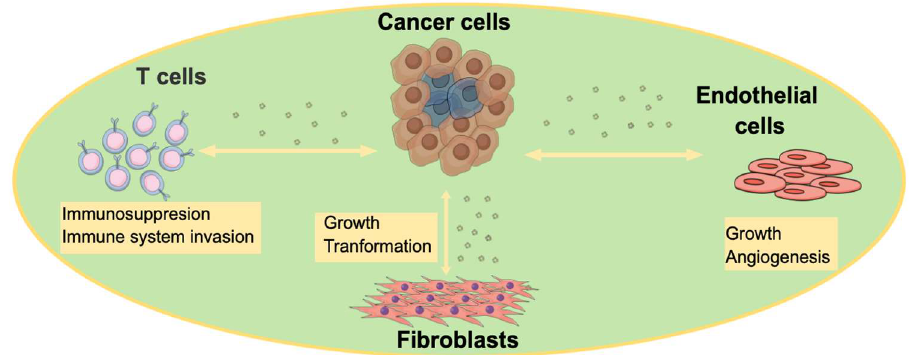
Figure 2. Schematic illustration depicting how cancer-cell-derived EVs affect various noncancer cell populations in the TME to favor cancer progression. Cancer cells secrete EVs to affect noncancer cells that comprise the TME (shaded area). Cancer-cell-derived EVs have the ability to increase the cell growth of both endothelial cells and fibroblasts within the TME. They also induce angiogenesis by targeting the endothelial cell machinery, and they transform fibroblasts into cancer-associated fibroblasts. Cancer-cell-derived EVs also target T cells to induce immunosuppression and promote immune invasion [1].